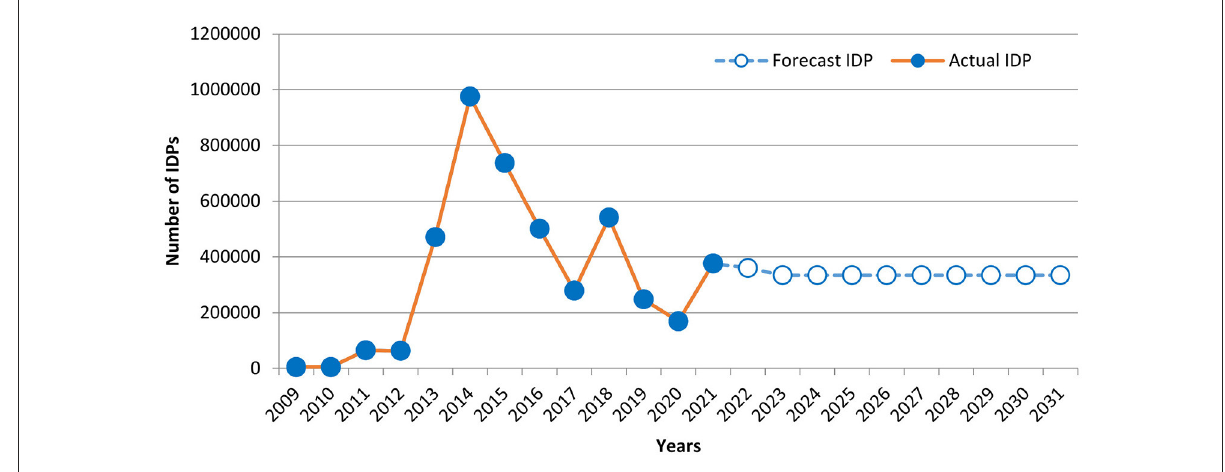
FIGURE1 Out-of-sample forecast plot with markers from 2022 to 2031.